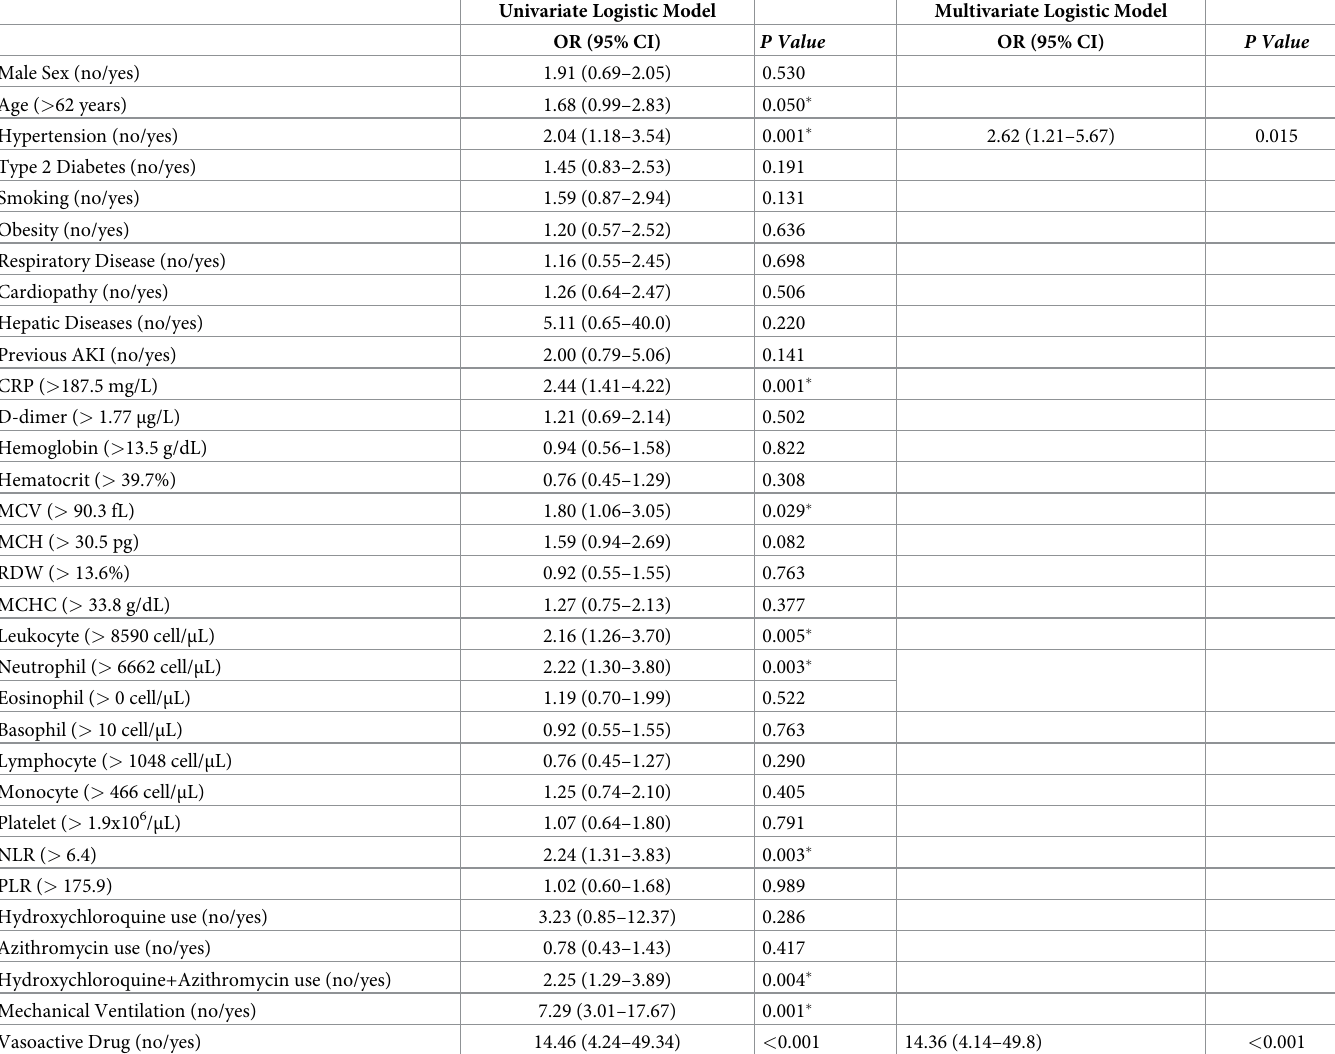
Table 3. Logistic regression analyses of factors associated with AKI in COVID-19-positive